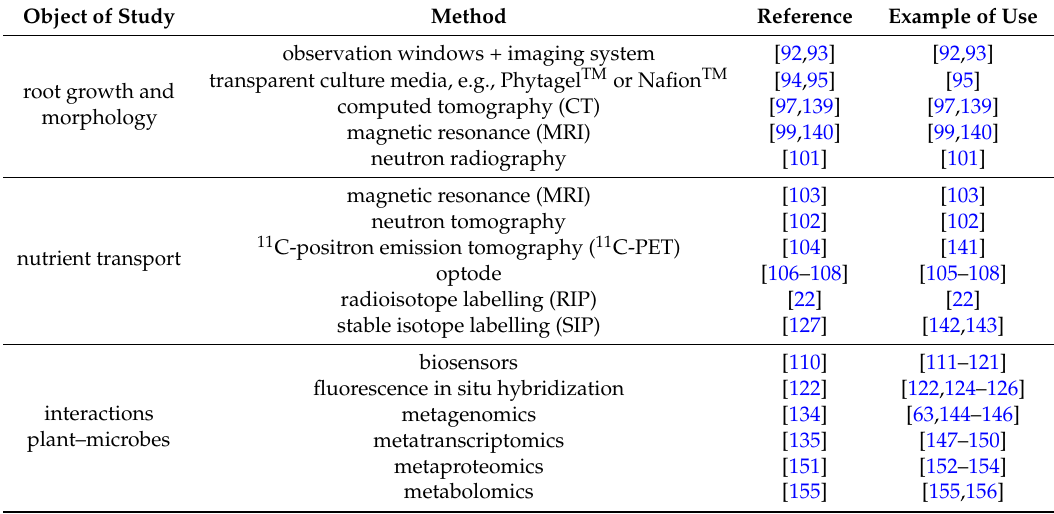
Table 1. An overview of methods used for describing roots and plant–microbe interactions in the